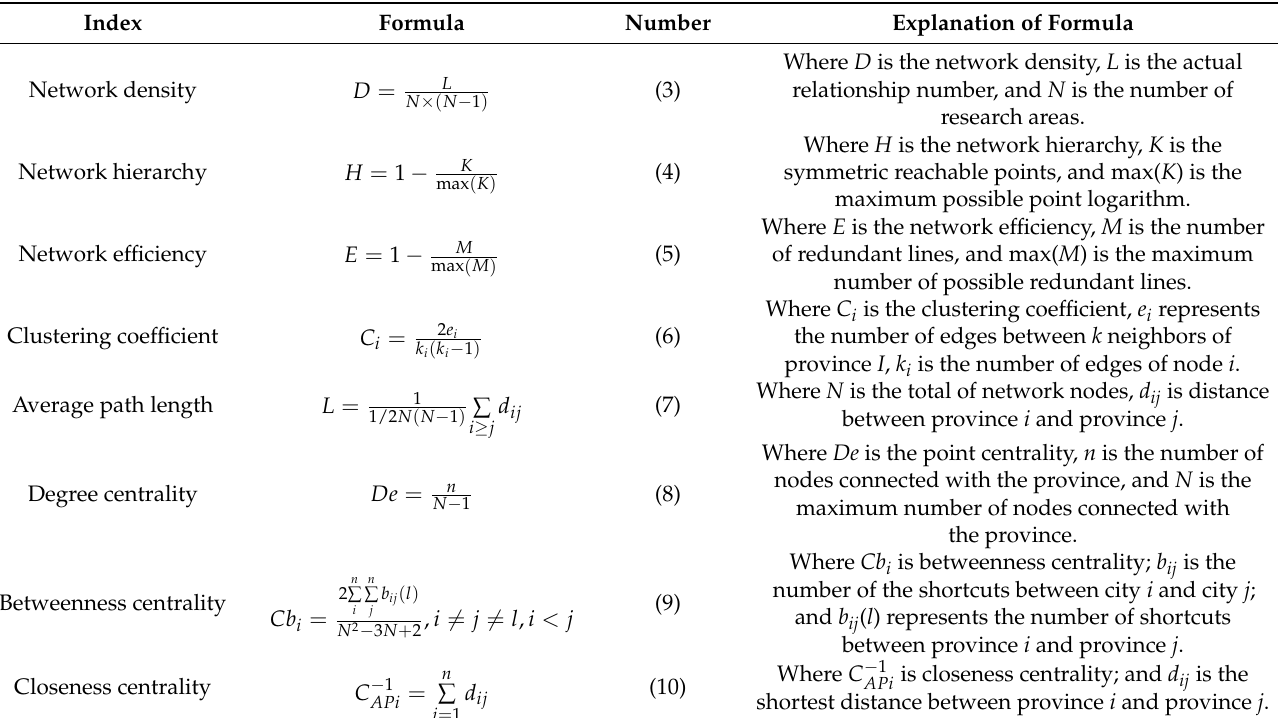
Table 1. Formulas of indicators regarding social network